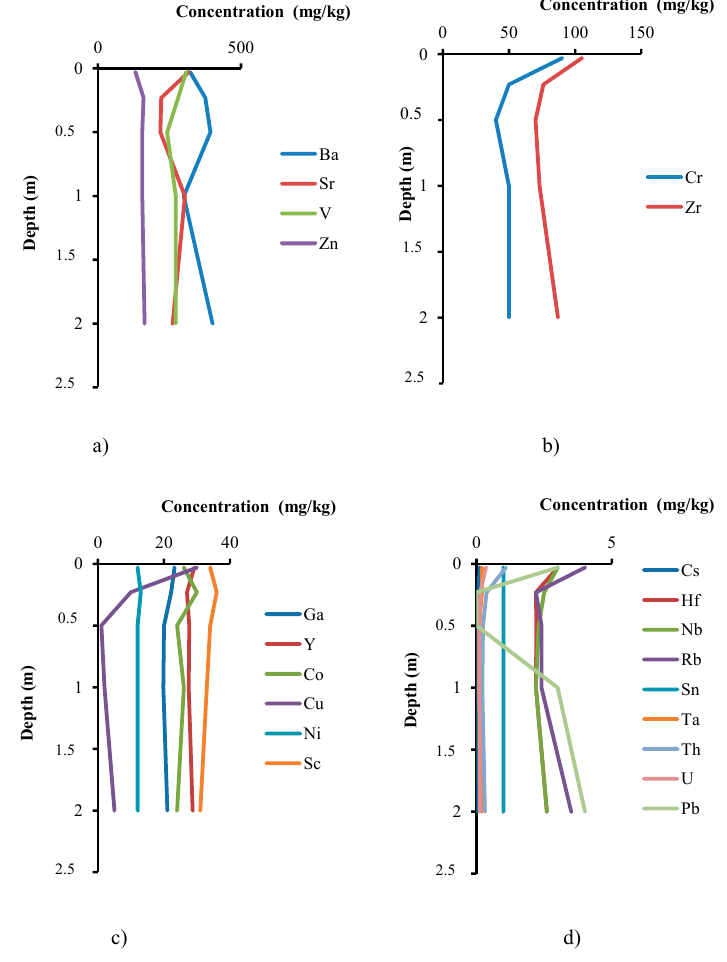
Figure 6. Evolution of trace elements with depth.